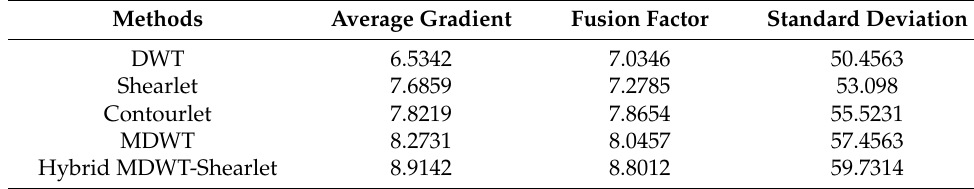
Table 6. Evaluation of fusion